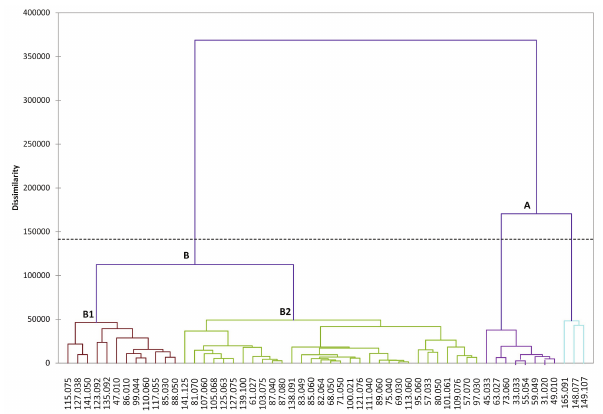
Fig. 4 - Dendrogram from cluster analysis of 90 Arabica sample based on 54 selected protonated m/z.